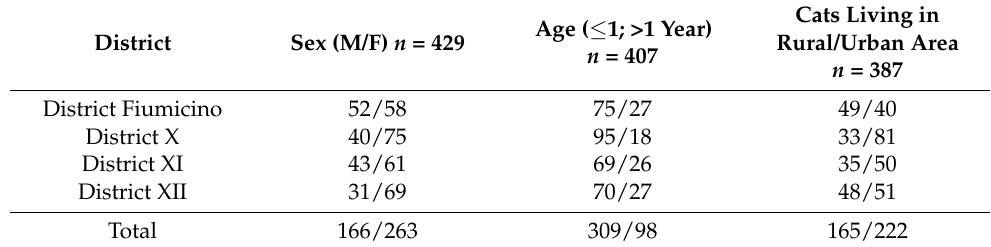
Table 1. Census of feline population under study and cats sampled per district. N. Surveyed N. Surveyed N. Cats to Be Sampled N. Sampled District Cats Colonies (N. Colonies) Cats District 3645 302 107 (9) 114 Fiumicino District X 8124 714 107 (9) 115 District XI 2924 265 107 (10) 106 District XII 2070 185 107 (10) 100 TOTAL 16763 1466 428 435 Table 2. Distribution of all sampled ( n = 435) cats per district according to sex, age and living area. Cats Living in Age ( ≤ 1; >1 Year) Rural/Urban Area District Sex (M/F) n = 429 n = 407 n = 387 District Fiumicino 52/58 75/27 49/40 District X 40/75 95/18 33/81 District XI 43/61 69/26 35/50 District XII 31/69 70/27 48/51 Total 166/263 309/98